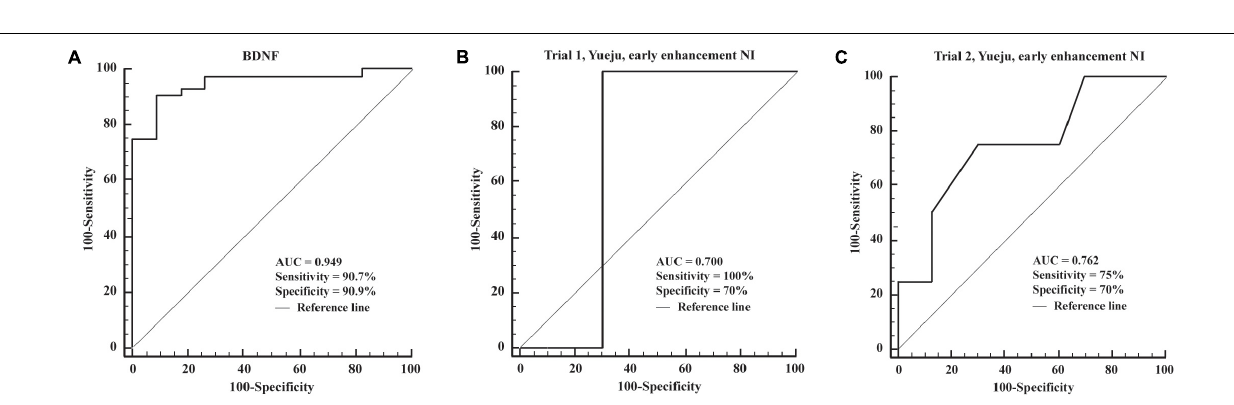
Frontiers in Behavioral Neuroscience |